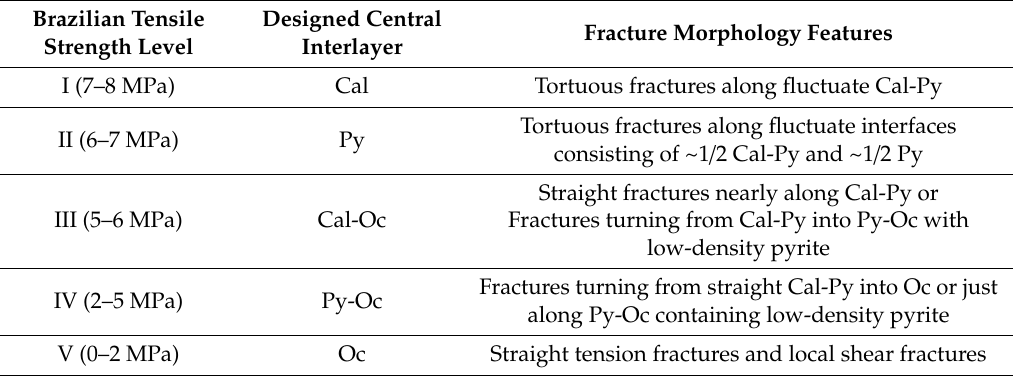
Table 3. Tensile strength levels and fracture morphology features of shale with various central laminae.